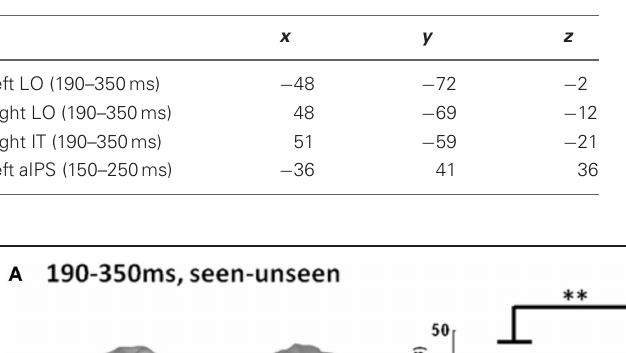
Table 1 | Talairach coordinates (mm) of the activated regions.